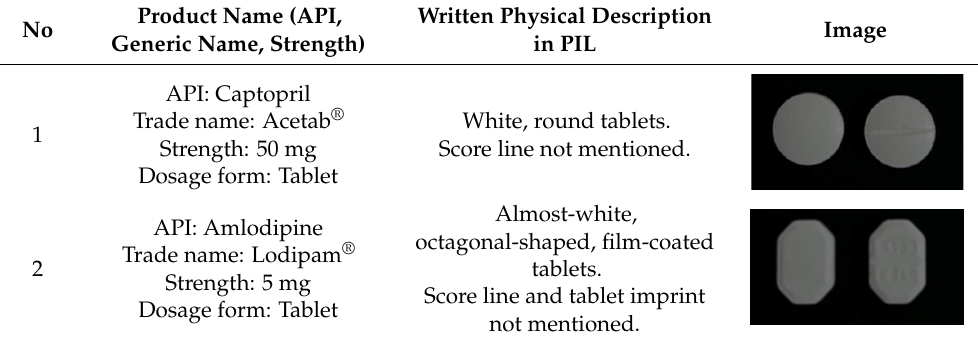
Table 4. Characteristics of pharmaceutical products with poorly written physical descriptions and matching.